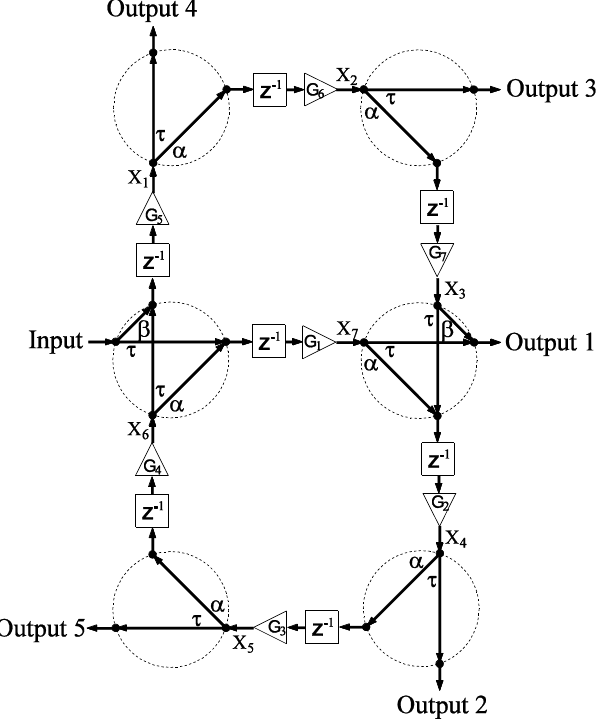
Figure 1. Network diagram of structure I. Transmitted,  , right-directed,  , and left- directed,  , coupler coefficient components. Photonic channelizer enabled by 6 two-port nano-photonic couplers, ....)3,2,1(  iG represent gain (triangles), 1  Z represent unit delay i (blocks), and X are internal states. Arrows indicate signal i